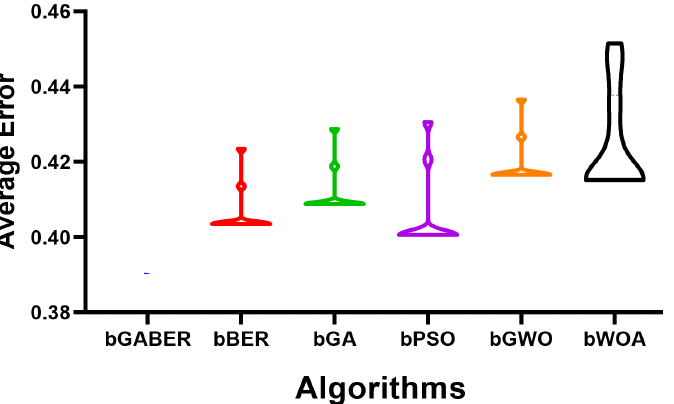
Figure 13. Average error of the results achieved by the proposed feature selection method compared to other methods based on the solar radiation dataset.